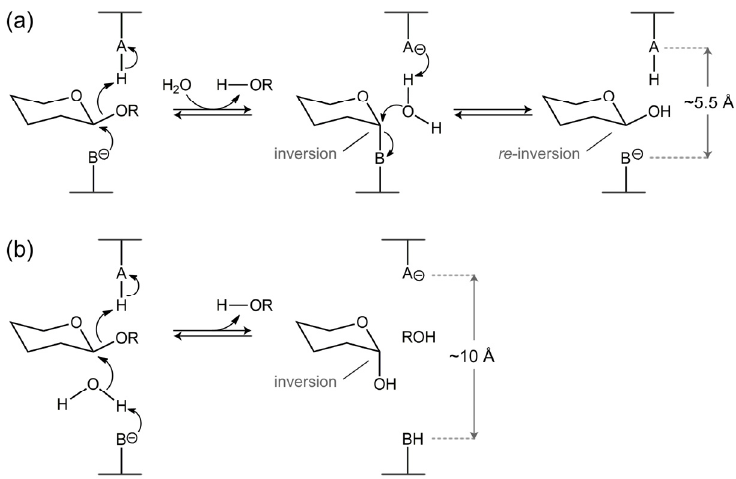
Figure 5. The two common types of catalysis by glycoside hydrolases as adapted from Davies and Henrissat [29]. ( a ) The retaining mechanism. The nucleophile and the general acid / base are represented as B - and AH, respectively. ( b ) The inverting mechanism. The general base and the general acid are represented as B - and AH, respectively. The typical distances of the catalytic residues in both mechanisms are indicated in Å. In most GHs, A and B are either Asp or Glu. See main text for further details.